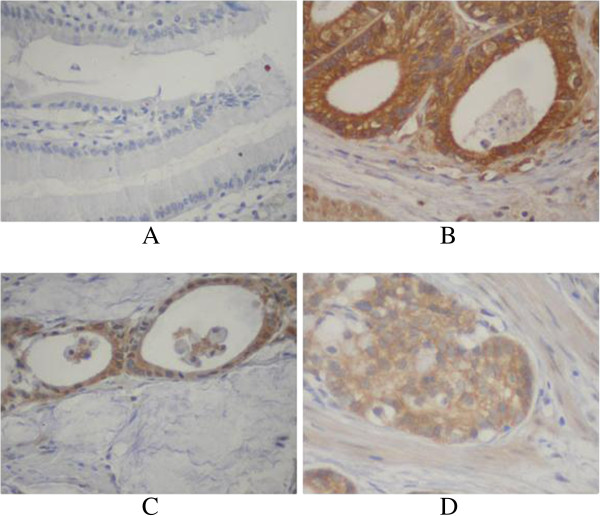
Immunohistochemical staining for EPCAM in gastric cancer lesions (601 case) and noncancerous tissues (92 case). A: EPCAM was negative in noncancerous tissues, B: EPCAM was highly expressed in well differentiated adenocarcinoma, C: EPCAM was highly expressed in moderately differentiated adenocarcinoma, D: EPCAM was highly expressed in poorly differentiated adenocarcinoma.